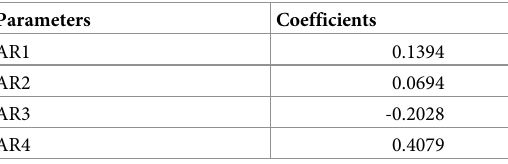
Table 4. Parameters of best fit ARIMA (4,1,0) model.